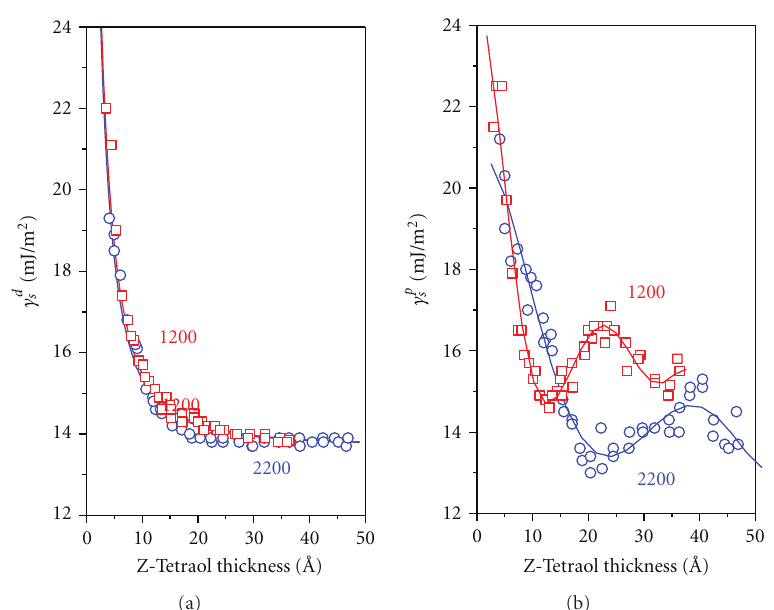
p s ) surface energy as a function of Z-Tetraol film thickness and